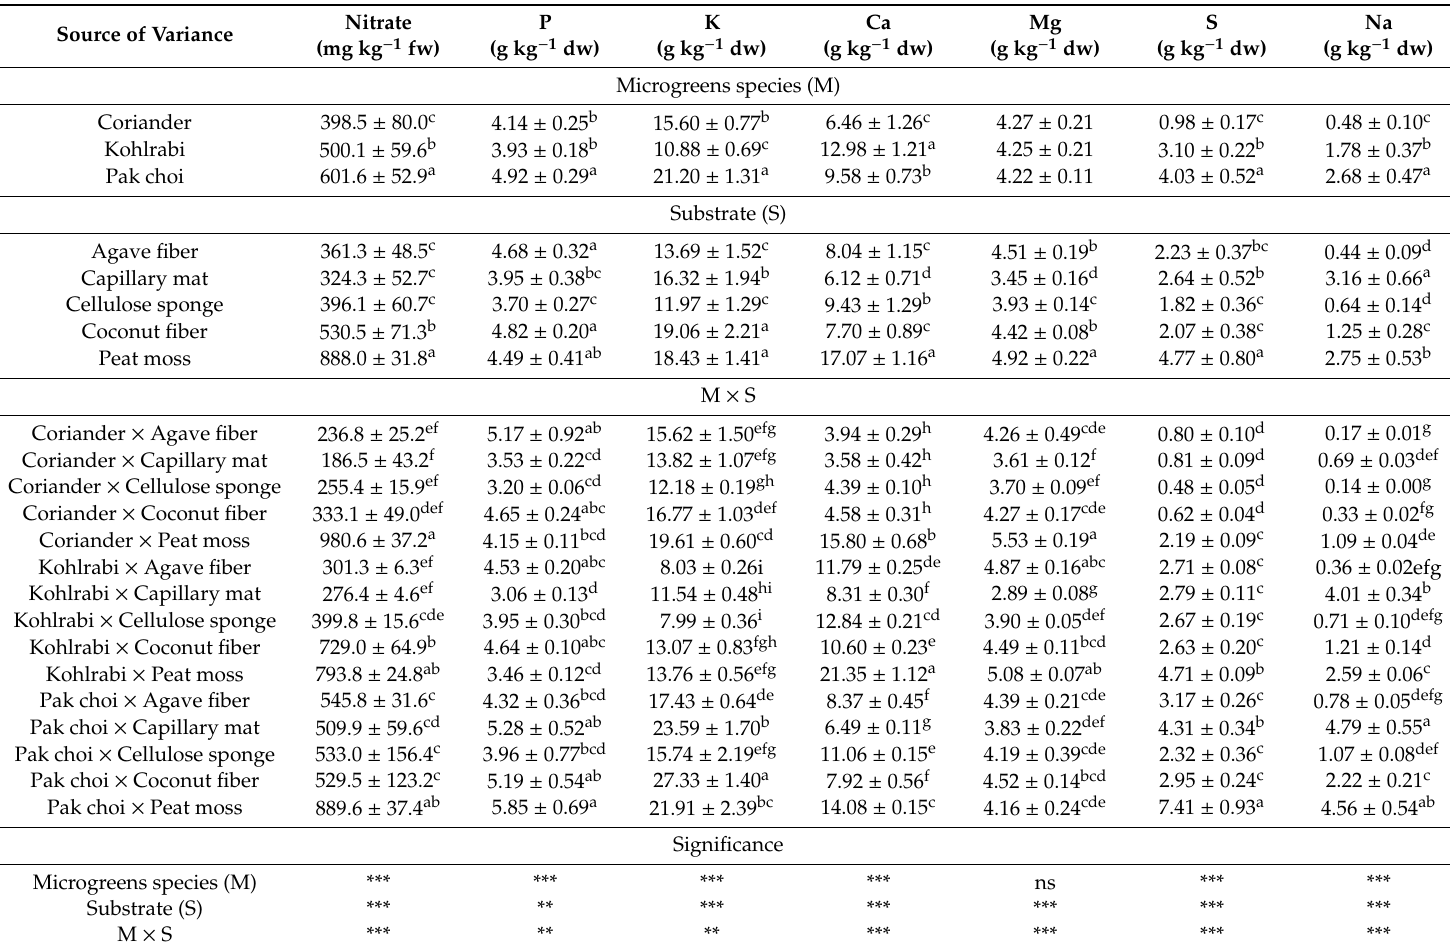
Table 3. Nitrate and mineral content of coriander, kohlrabi and pak choi substrates grown on natural fiber and synthetic substrates under a controlled environment. All data are expressed as mean ± standard error, n =